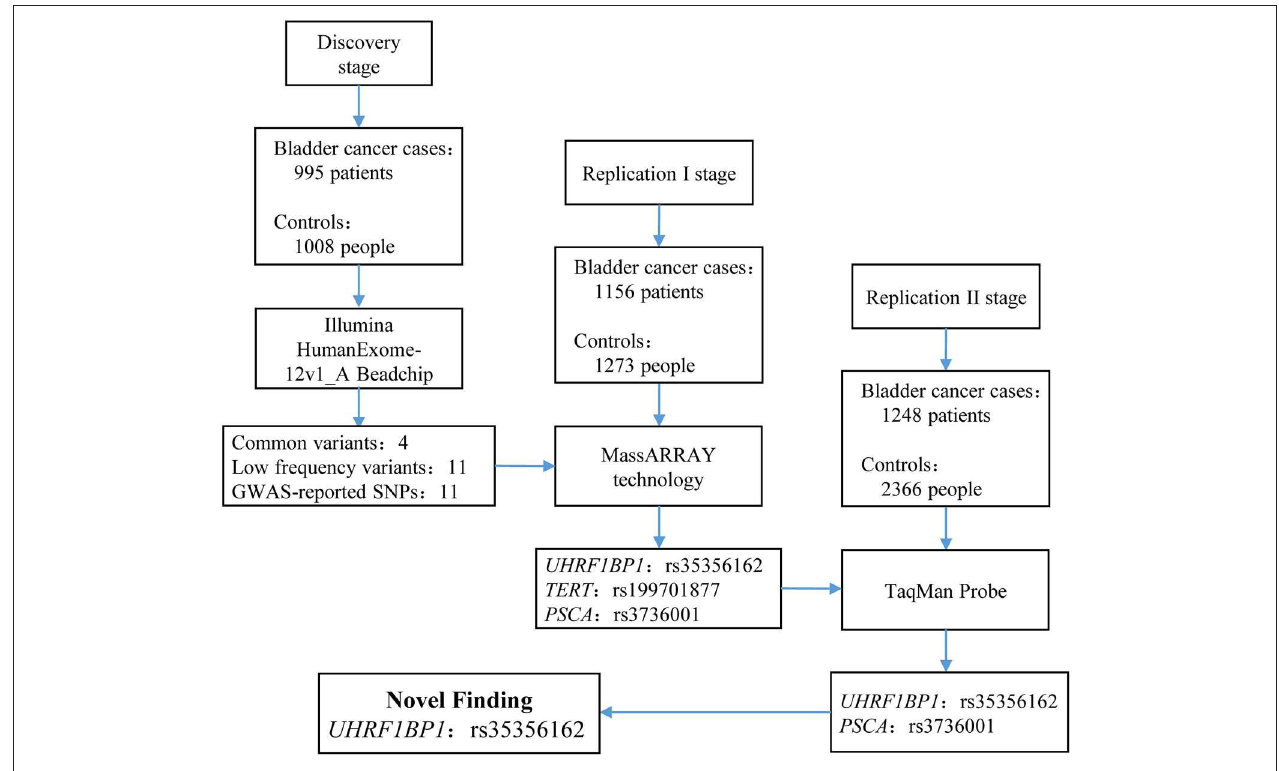
FIGURE 1 | Flow chart of study design and summary of the three-stage study. In discovery stage, we enrolled 995 bladder cancer cases and 1,008 controls to perform exome chip analysis. After filtering, 26 SNVs remained and entered into replication I stage for further validation via MassARRAY technology. In replication I stage, only 3 SNPs survived. These three SNPs entered into replication II stage for validation. Finally, only rs35356162 in UHRF1BP1 and rs3736001 in PSCA survived. However, only rs35356162 in UHRF1BP1 achieved statistical significance after Bonferroni adjustment. More study design supplements and aim of each stage can be found in Supplementary Materials and Methods .